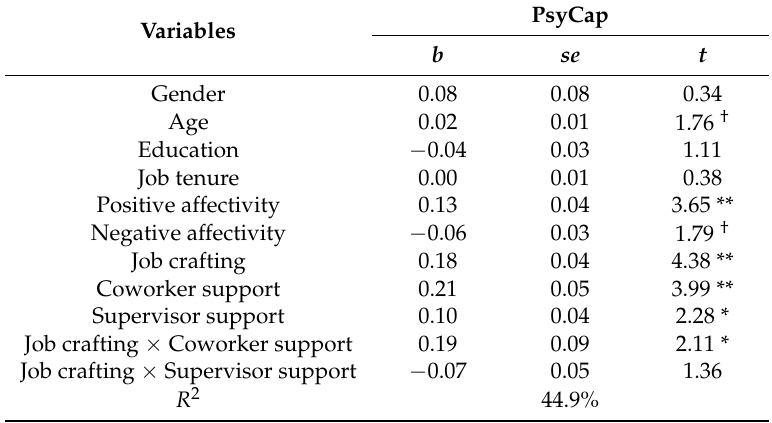
Table 4. PsyCap regressed on the moderation term of job crafting and coworker support.